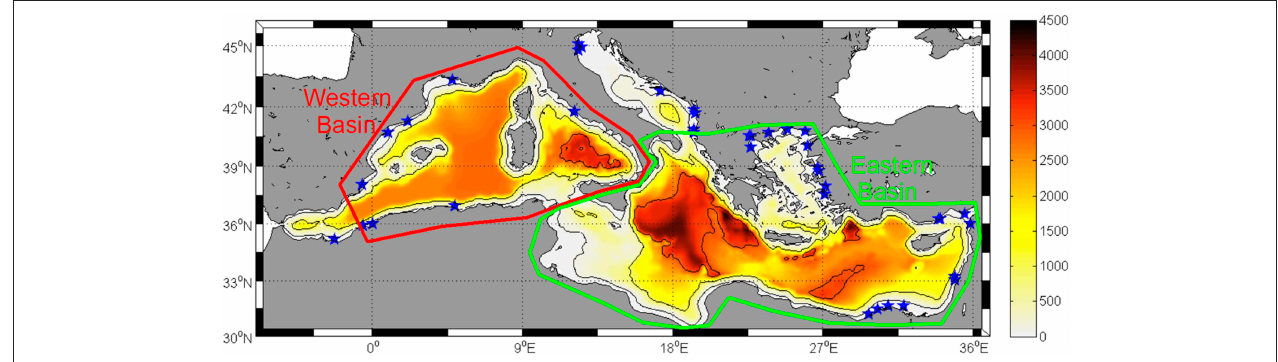
FIGURE 1 | Model domain with bathymetry (background color). Blue stars indicate the position of the river mouths included in the model. The red and green polygons indicate the areas considered as Western and Eastern basins in this work.